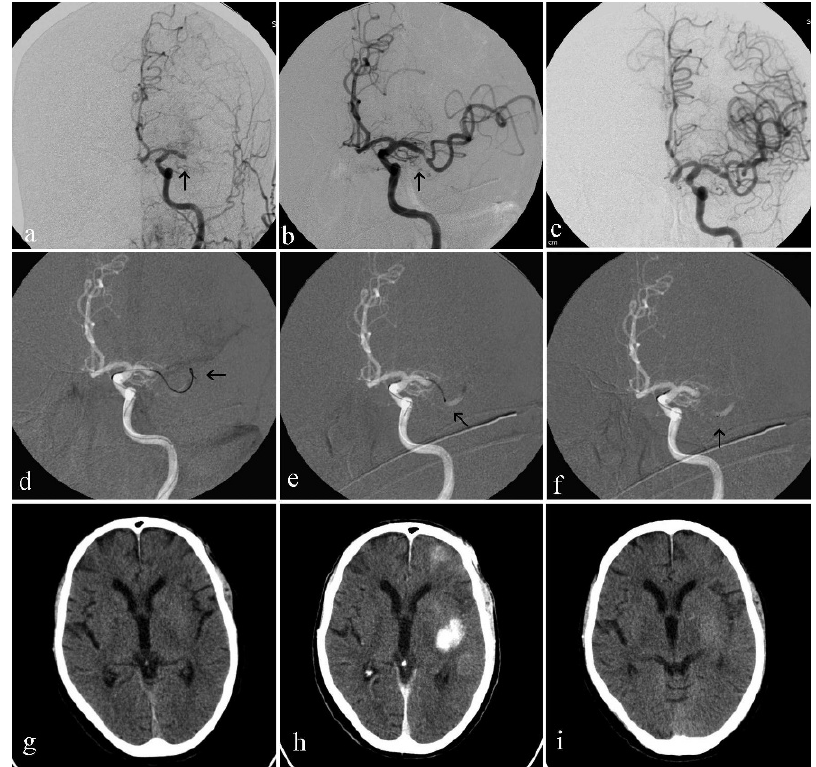
Figure 2 - (a) DSA of the left common carotid artery (LCCA), arterial phase, frontal view, shows a proximal occlusion of M1 segment of left middle cerebral artery (LMCA) (black arrow); (b) DSA of left interna carotid artery (LICA), arterial phase, frontal view, shows a Solitaire AB (ev3, Irvine, CA, USA) deployed into the M1 segment and promptly flow restoration of LMCA (black arrow); (c) Final control DSA of the LCCA, arterial phase, frontal view, shows the complete recanalization of the LMCA; (d, e, f) road maps of LICA, frontal views, show (d) the microwire crossed the occluded LMCA (black arrow), (e) the terminal tip of the microcatheter (black arrow) placed beyond the thrombi into the M1 segment of the LMCA and (f) terminal radiopaque marks of a 4x20 mm Solitaire AB device (ev3) deployed into the occluded site of LMCA; (g, h, i) Brain CT scans, (g) performed on presentation revealing no signs of hemorrhage or ischemic injury, (h) performed immediately after intra-arterial thrombectomy showing contrast medium enhance in the left middle cerebral artery territory and (i) performed 48 hours after intra-arterial thrombectomy showing contrast medium cleared and slight parenchymal